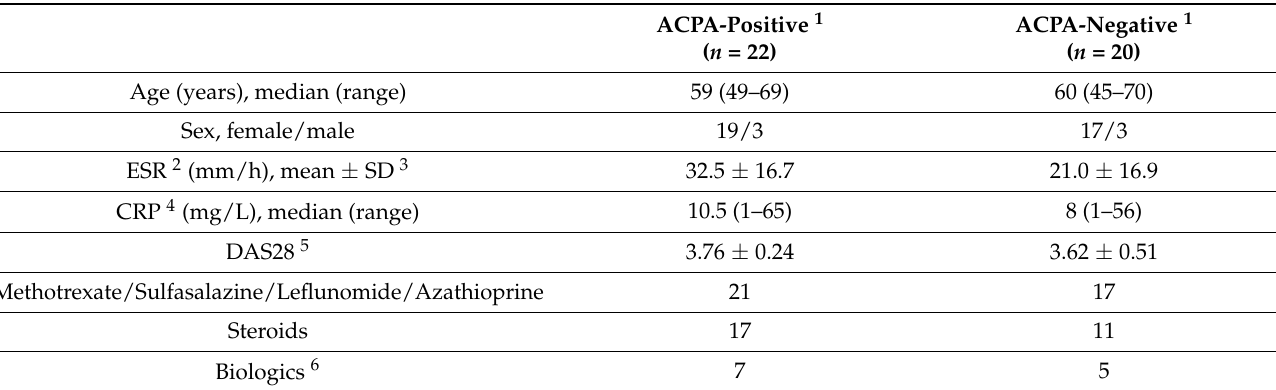
Table 1. Patient’s